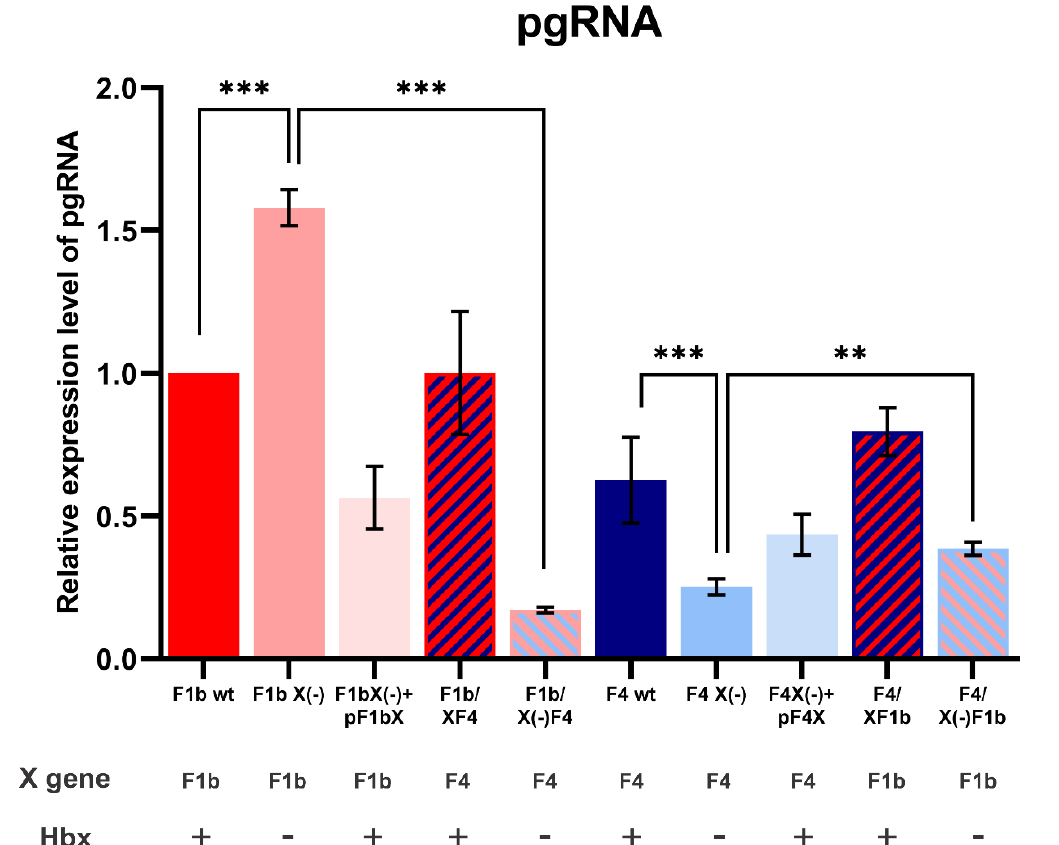
Figure 5. Analysis of pgRNA levels of sgtF1b and sgtF4 variants. HuH-7 cells were transfected with linear full-length HBV genomes F1b wt, F1b X(-), F1b X(-) + pF1bX, F1b / XF4, F1b / X(-)F4, F4 wt, F4 X(-), F4 X(-) + pF4X, F4 / XF1b and F4 / X(-)F1b variants. Seventy-two hours post-transfection, total RNA was extracted and pgRNA was quantified by RT-qPCR using specific primers. β -actin amplification